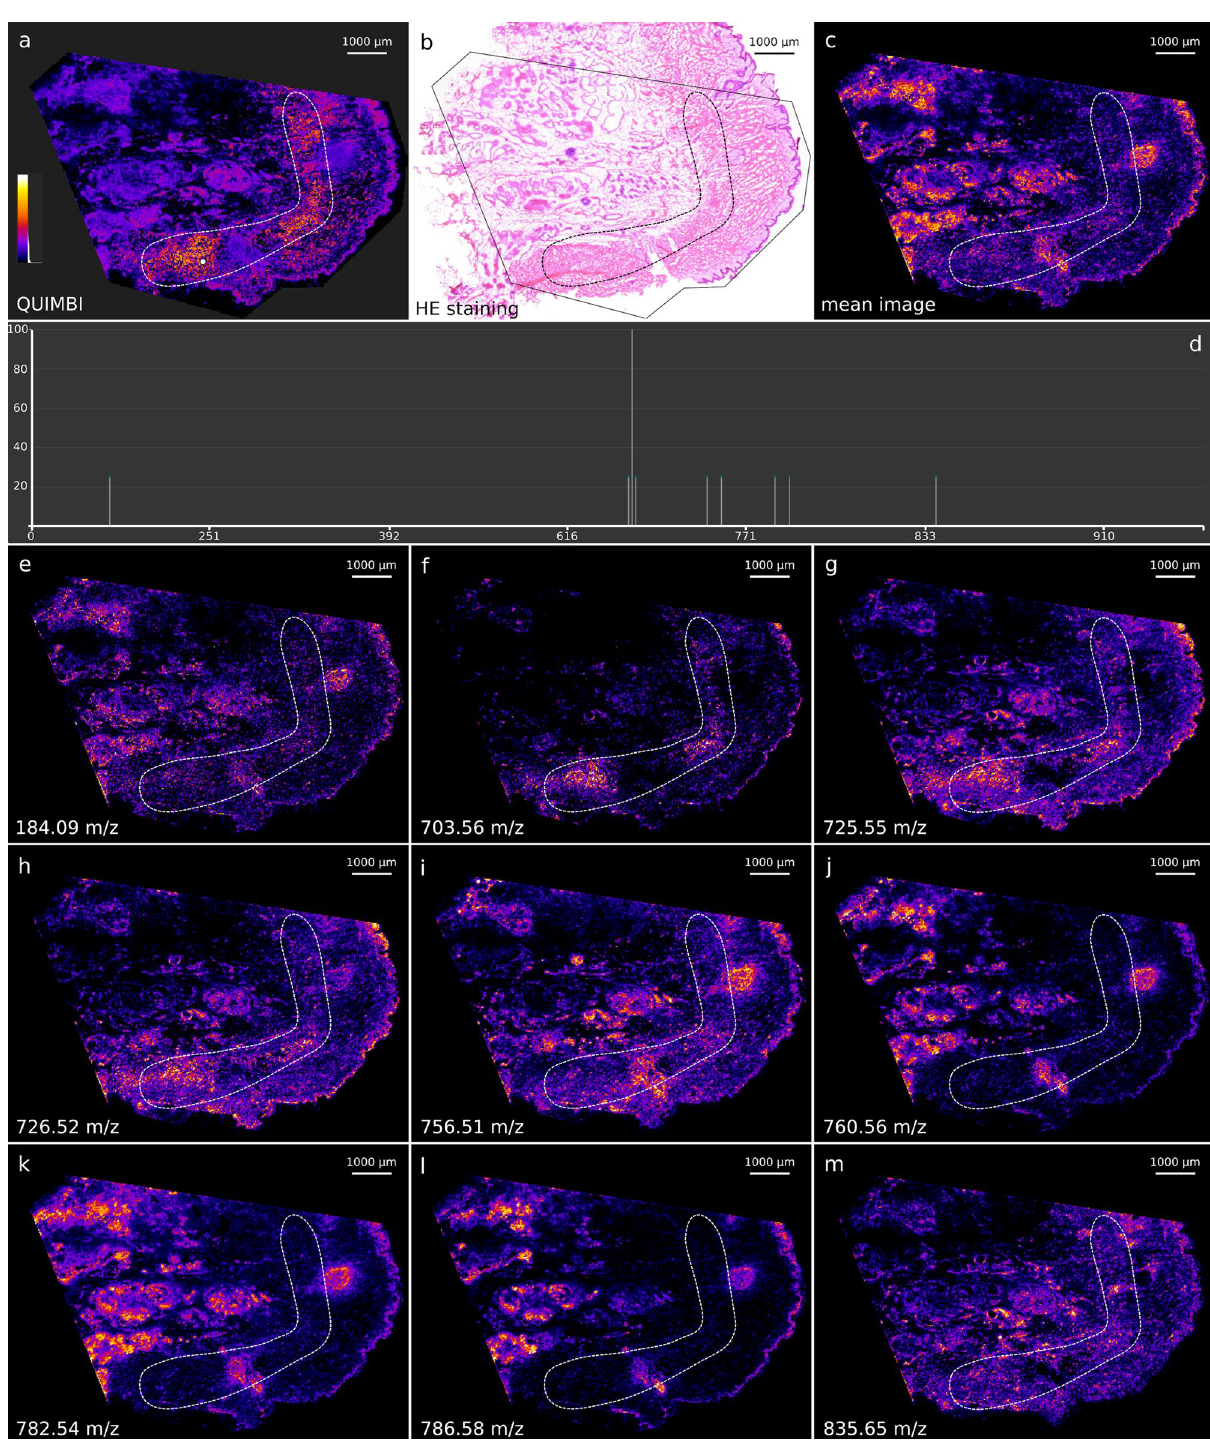
Figure 8. QUIMBI visualization of human PXE skin showing a calcification layer ( a ), with corresponding histology ( b ), mean image of all mass channels ( c ) and single mass channel images ( e )–( m ). The image intensity scale in ( a ) shows the similarity of pixels from black (dissimilar) to white (similar). The QUIMBI visualization in ( a ) shows a distribution of weak signals for the selected reference pixel (white circle in a ). The dashed line in the QUIMBI visualization ( a ) marks a calcification layer in the skin that is characteristic for PXE. In ( d ) the mass spectrum belonging to the reference pixel selected in ( a ) can be seen, which shows nine mass channels with non-zero signal. In ( e )–( m ) the single mass channel images are shown. The mean image of the nine mass channels is shown in ( c ). In all images, the region shown in ( a ) is marked with a dashed line. Only the QUIMBI visualization fully reveals the calcification